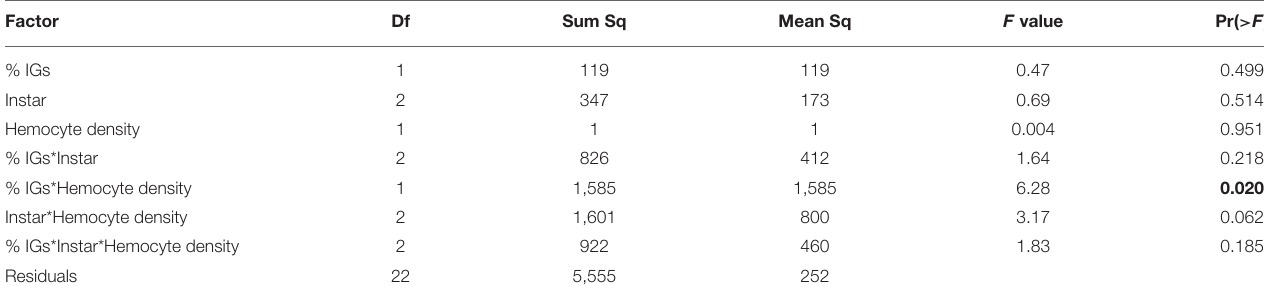
TABLE 3 | For caterpillars reared on Plantago in January, ANCOVA showed an interaction between percent dry weight total IGs sequestered and hemocyte density on